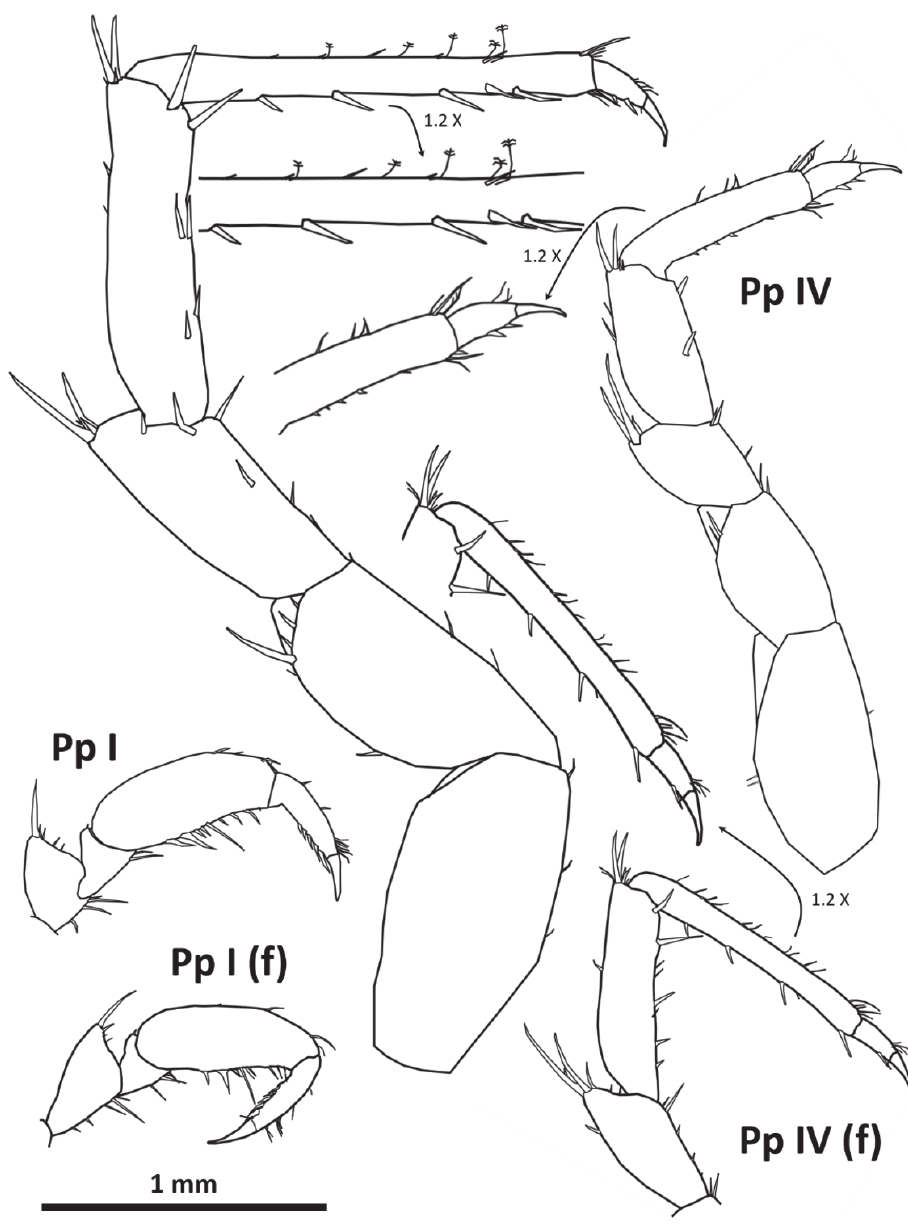
Figure 5. Asellus ismailsezarii sp. nov., Ganow spring, Western Iran. Holotype male, 8.2 mm: Pp I, IV, VII – pereopods I (distal articles), IV, VII. Female, 8.1 mm: Pp I, IV (f) – distal articles of pereopods I, with around 7 spiniform setae along inferodistal margins of merus, and a group of around 4 spiniform setae on superiodistal angle of merus VII, longest one 42% ( ♂♂ : 42–58%; ♀♀ : 44–53%) of merus length. Carpus VII with around 6 strong spiniform setae along inferior and inferodistal margins, few (around 2) weaker spiniform setae